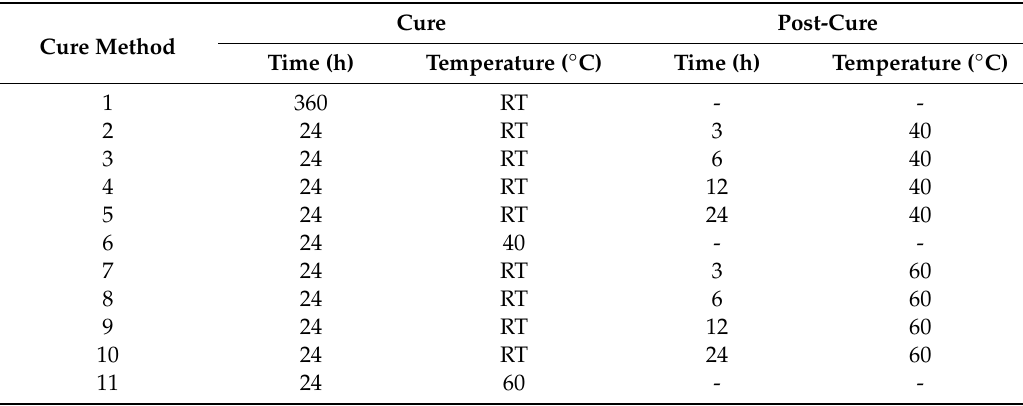
Table 1. Summary of cure and post-cure